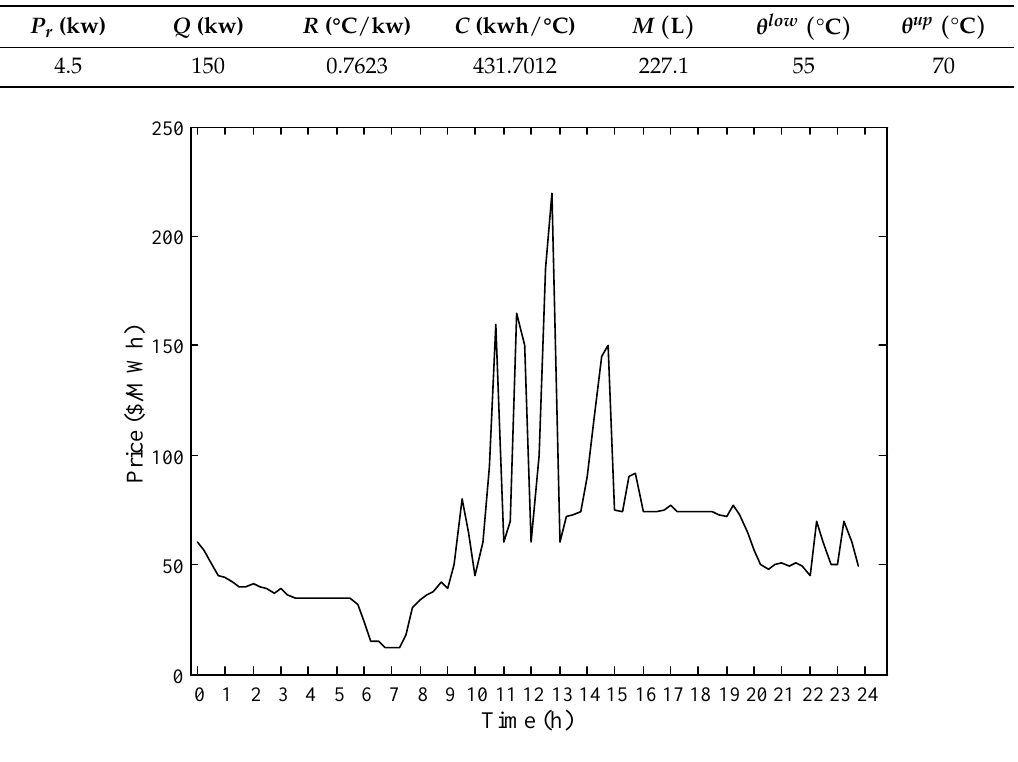
Figure 2. Real-time pricing ( RTP) prices for next day.